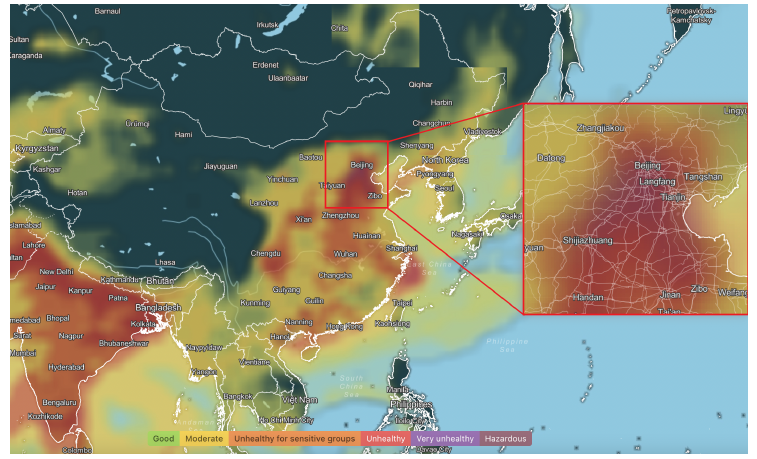
Figure 2. Schematic diagram of the air quality index in the Beijing-Tianjin-Hebei region of China.